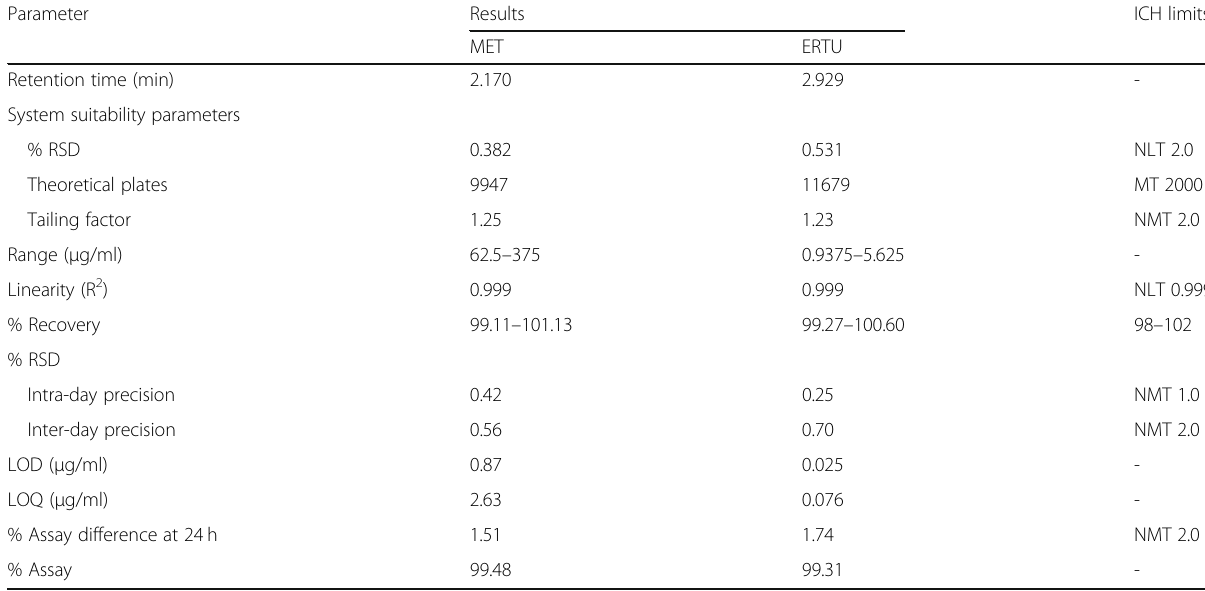
Table 7 Summary of validation parameters of ERTU and